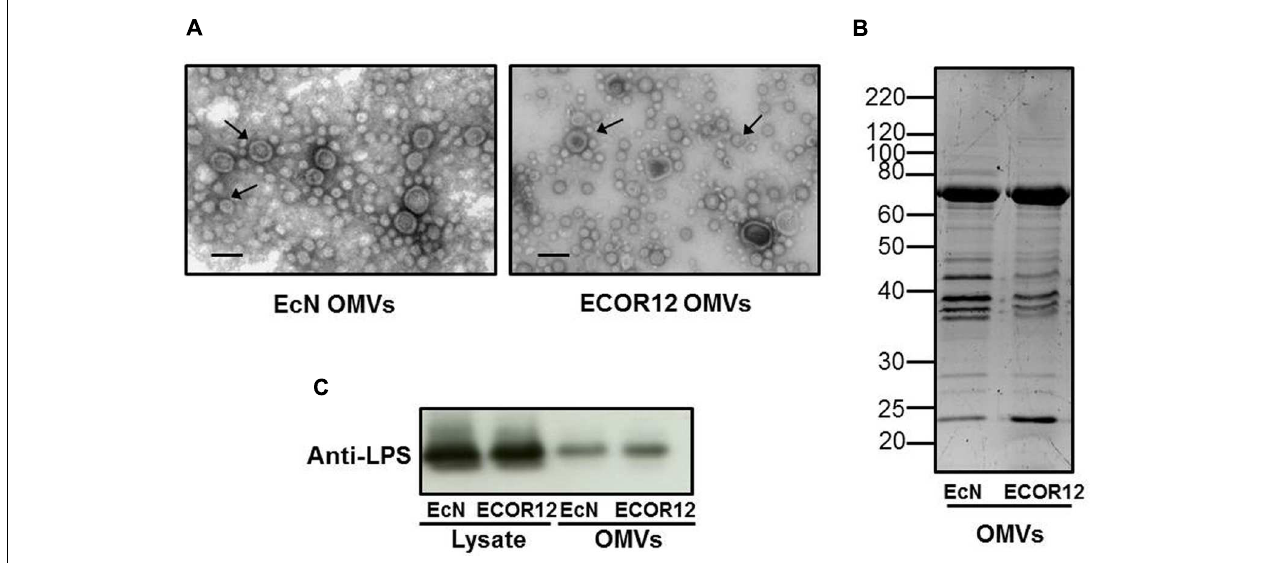
FIGURE 1 | Analysis of EcN and ECOR12 OMVs. (A) Negative staining electron microscopy of isolated vesicles. OMVs are indicated by arrowheads. Bar = 50 nm. (B) Comparison of the protein profile of EcN and ECOR12 OMVs. Isolated vesicles (10 µ g) were separated in a 10%-SDS-PAGE gel and stained with Sypro R (cid:13) Ruby. Molecular size markers are indicated. (C) Western blot analysis of LPS in OMVs (0.1 µ g protein) or in bacterial lysates (10 µ g protein) obtained from the indicated